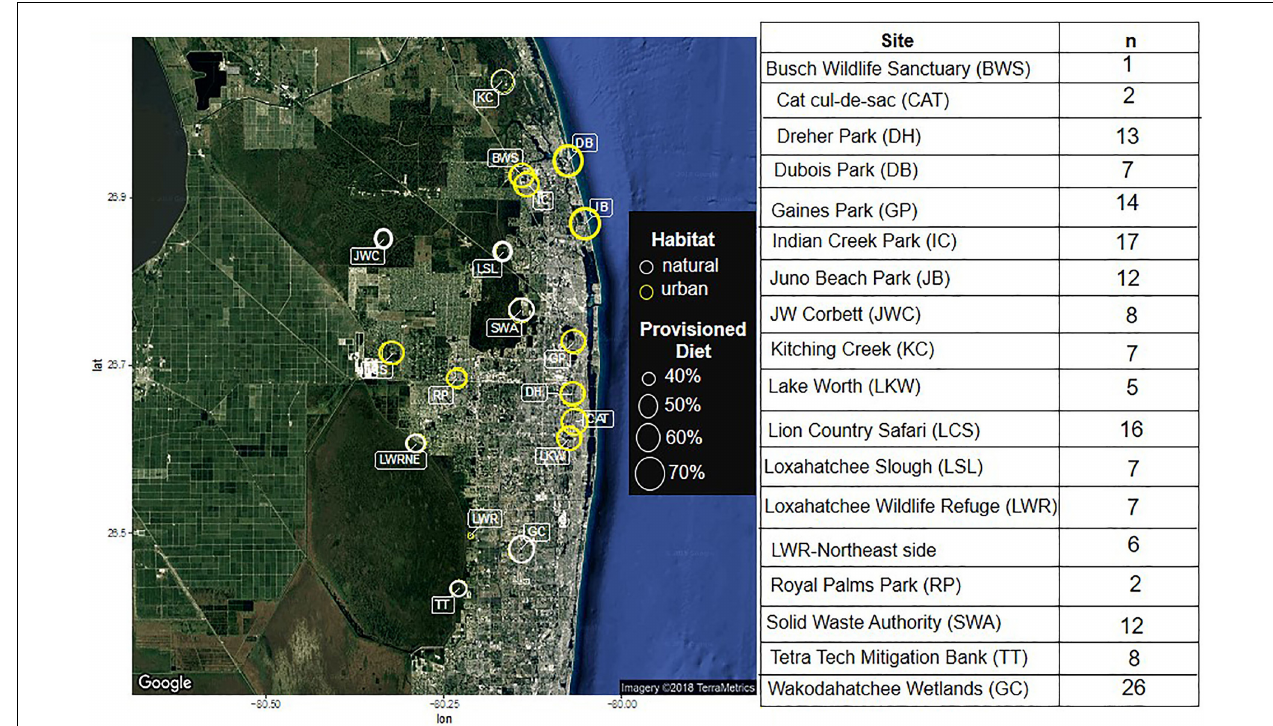
FIGURE 1 | A diagram of the sampling locations, with urban environments circled in yellow and natural environments circled in white. The size of the circle indicates the proportion of the diet that contains anthropogenic sources, as indicated by radioisotope analyses conducted in Murray et al. (2018). The table contains the number of animals captured at each